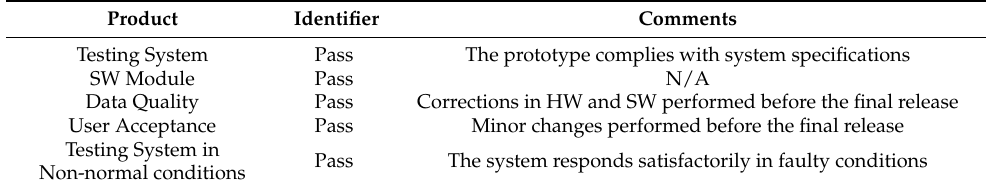
Table 4. Overall Testing Outcome per